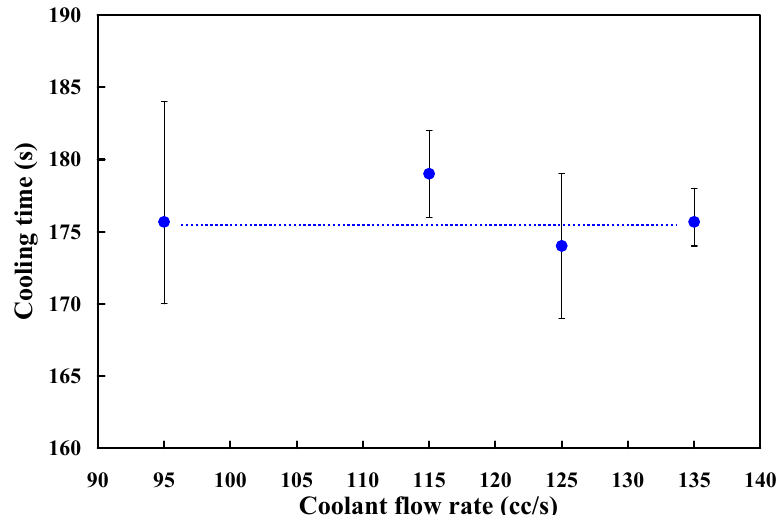
Figure 22. Cooling times of the molded parts as a function of different coolant flow rates.